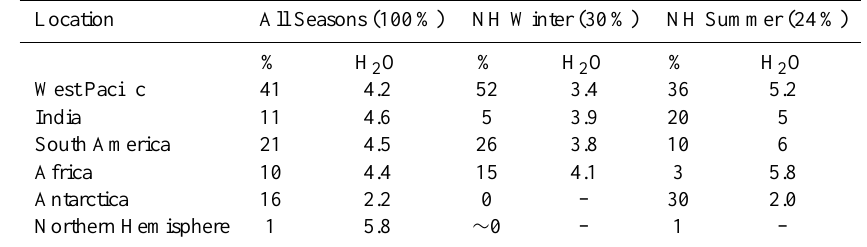
Table 2. Dehydration Statistics by